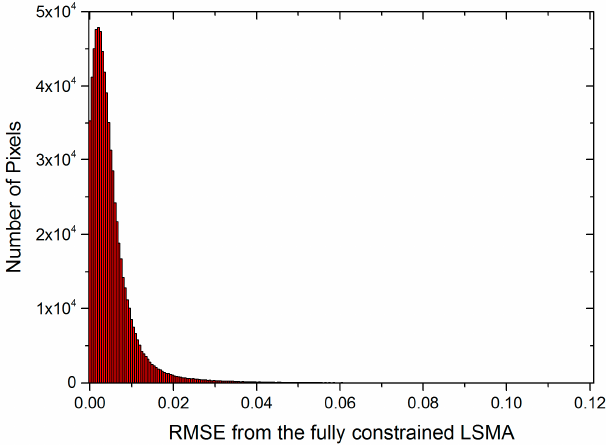
Figure 5. RMSE image resulting from the fully constrained LSMA. Remote Sens. 2017 , 9 , x FOR PEER REVIEW